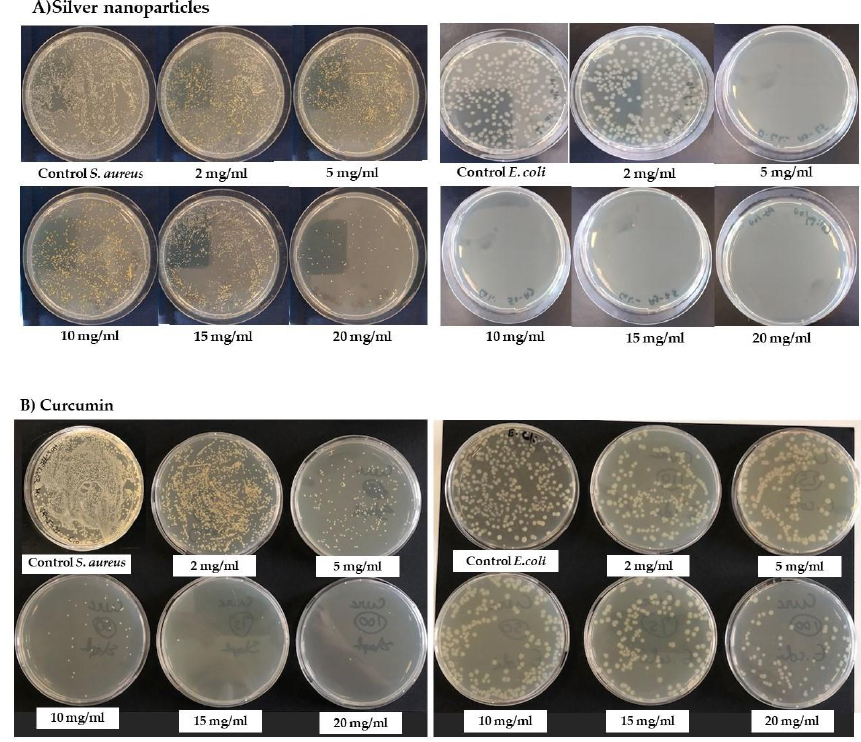
Figure 6. Antibacterial activity assays against Staphylococcus aureus and Escherichia coli. ( A ) Activity of silver nanoparticles. ( B ) Activity of curcumin.